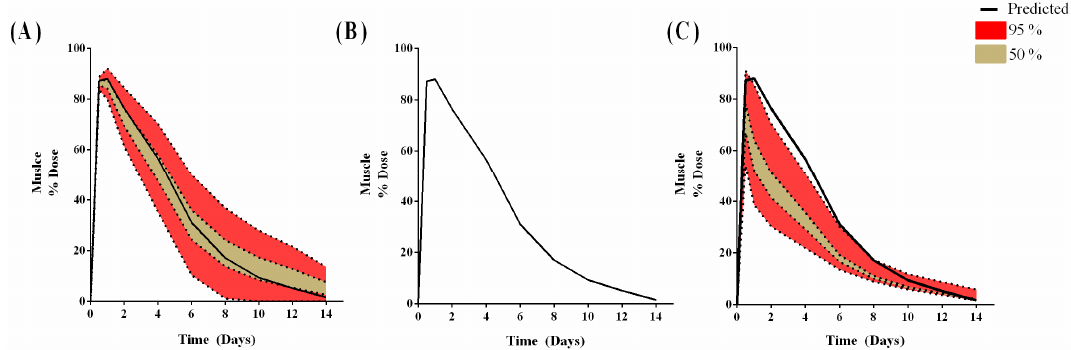
Figure 7. The uncertainty in the antigen muscle concentrations, following 1000 model simulations with a 3-fold change in k deg,muscle ( A ); 1 × 10 − 8 to 1 × 10 − 5 change in f e ( B ) and 1 × 10 − 5 to 1 × 10 − 1 change in f e ( C ) was simulated. The solid line represents PBPK-predicted profiles.